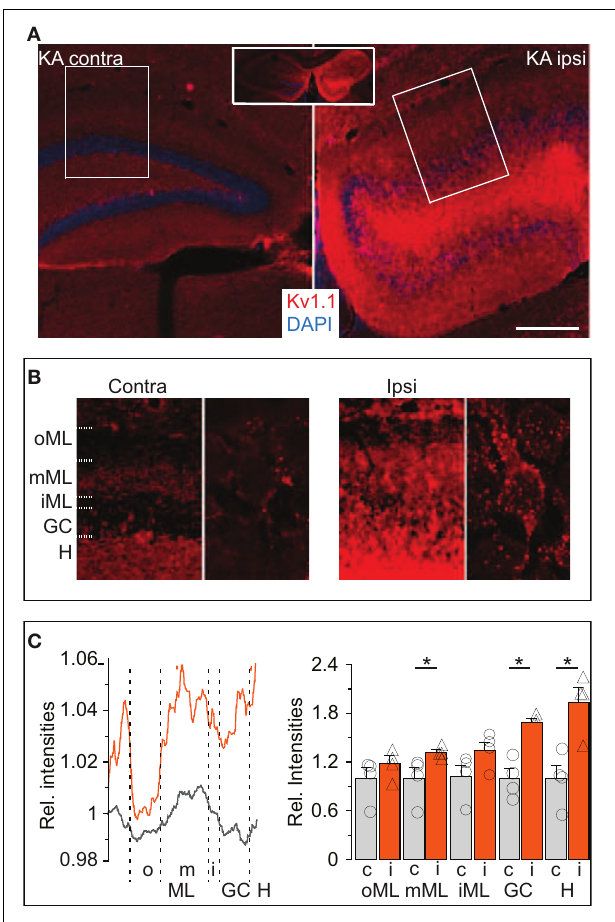
FIGURE 5 | Expression of Kv1.1 proteins is more abundant in the KA-injected hippocampi. (A) Overview ( inset , both hemispheres) of immunofluorescence labeling of Kv1.1 channel proteins ( red ) strongly enhanced in the ( ipsilateral, Ipsi ) KA-injected hippocampus compared to the non-injected ( contralateral, Contra ) side. Sections were co-labelled with DAPI ( blue ). Scale bar , 500 μ m. (B) Magnified regions of interest acquired with identical microscope settings ( left panels of Contra and Ipsi , ROIs boxed in (A) respectively; right panels , further magnified single cells, respectively). Contralateral Kv1.1 signal intensities were larger in the hilus ( H ) and middle molecular layer ( mML , see Results) compared to the DG cell soma layer ( GC ) as well as outer and inner ML ( oML, iML, respectively). Ipsilateral Kv1.1 signals also formed a band in the mML, but in addition showed strong Kv1.1 labeling in the GC, iML and H. At higher magnification, contralateral DG cells show little Kv1.1 in the GC layer ( right panels in Contra and Ipsi ). However, the KA side shows abundant Kv1.1 punctae decorating DG somata which may belong to somatodendritic membranes of DG cells or backsprouted mossy fibers ( Ipsi , right panel ). (C) Relative quantification of Kv1.1 fluorescence intensities by line profiles ( left panel ) or surface areas ( right panel ) from ROIs as in (B) . The line profile ( left panel ) shows a distinctive band in the mML contra- and ipsilateral. The relative amount of Kv1.1 signal is enhanced ipsilateral in almost all dentate regions.